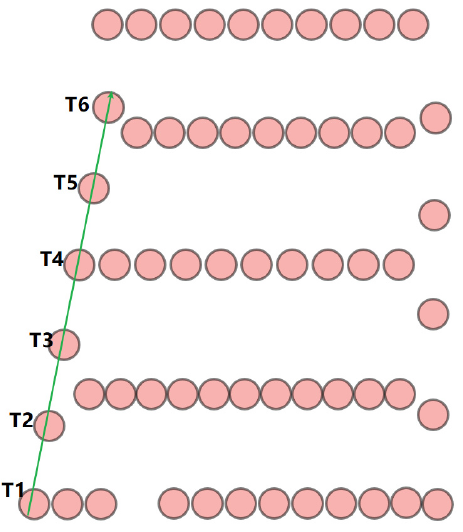
Figure 5. Wind direction is 17-degree.